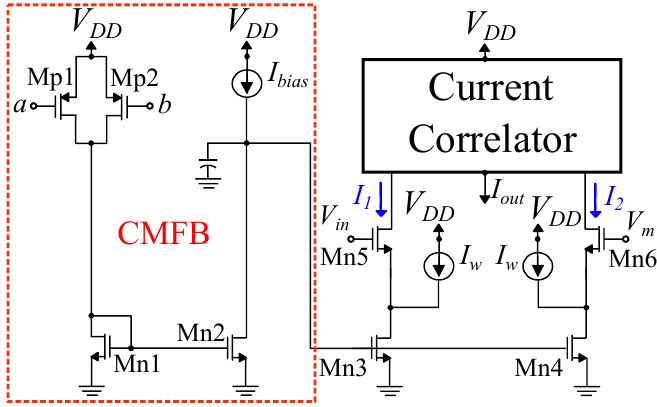
Figure 29. A Gaussian function circuit with a CMFB